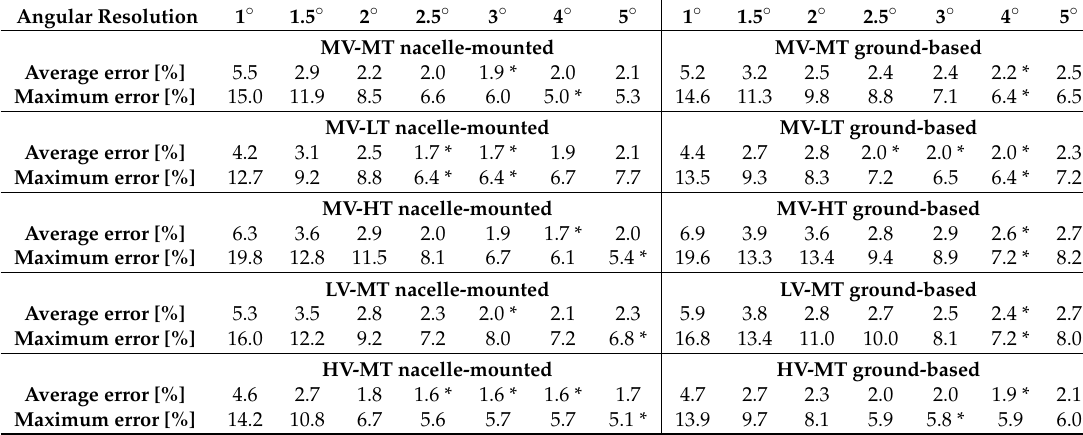
Table A2. Total average and maximum errors for the reconstruction of σ u ( x , y , z ) inside the volume of interest for all inflow cases studied and both lidar locations. The errors are shown as a percentage of the undisturbed wind speed at hub height (see Section 2.1.3). The errors corresponding to an optimum angular resolution for each case are identified with an